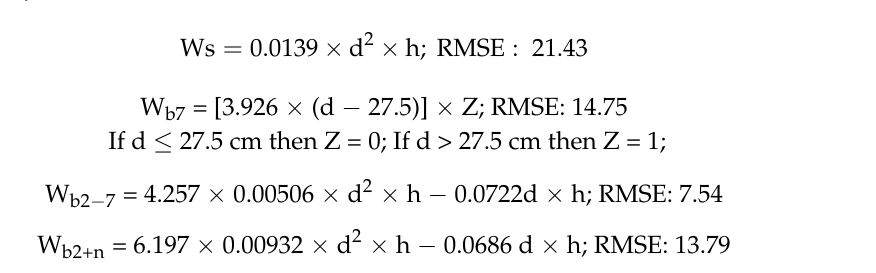
Ws: Biomass weight of the stem fraction. W b7 : Biomass weight of the thick branch fraction with a diameter greater than 7 cm; W b2–7 : Biomass weight of the medium branch fraction with a diameter between 2 and 7 cm; W b2+n : Biomass weight of the thin branch fraction with a diameter smaller than 2 cm, with needles (all in kg); d = dbh (cm); h = tree height (m). Overall biomass (W t ) was expressed in Mg ha − 1 (Table 1). A standard coefficient of 0.5 [38] was used to obtain the biomass C content. Table 1. Silvicultural characteristics, biomass and soil organic carbon stocks (Mg ha − 1 ) of Pinus halepensis plantations according to the thinning intensity (C, Control or unthinned plots; T30, light thinning, 30% basal area removed; T50, heavy thinning, 50% of basal area removed) at Los Cuadros (Murcia, Spain). Variables and abbreviations: stem density (D, trees ha − 1 ); height (H, m); diameter at breast height (dbh, cm); basal area (G, m 2 ha − 1 ), Biomass C stock (W t , Mg C ha − 1 ) and Soil Organic Carbon stock (SOC depth –S, Mg C ha − 1 ). Values are means ± SE. Different letters indicate significant post-hoc differences between thinning treatments at alpha = 0.05 based on a one-way ANOVA. Control Moderate Thinning Heavy